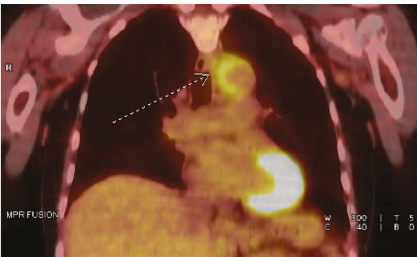
Figure 2: Positron emission tomography scan showing resolution of aortitis. This PET scan was done approximately three months after beginning prednisone and did not show any of the previous areas of increased metabolic activity or inflammation. It also did not show any evidence of recurrence of her metastatic